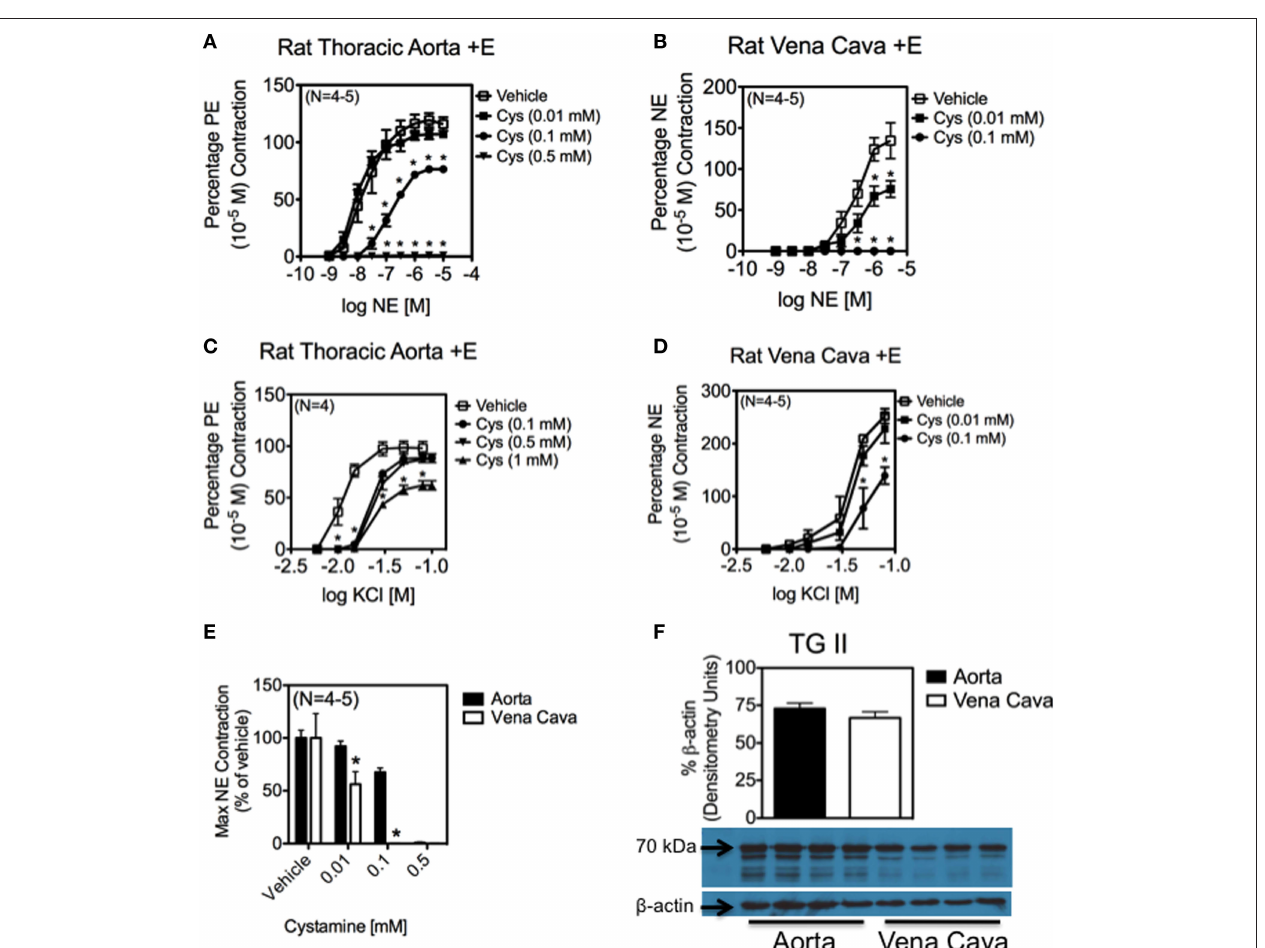
bottom left) showed that NE-biotin entered the smooth muscle cells (indicated by α -actin staining, green, top right), and, in the vena cava, other vascular cells (red staining, bottom right of the vena cava). Nuclei are indicated by DAPI staining. Images are representative of tissues from four different rats.